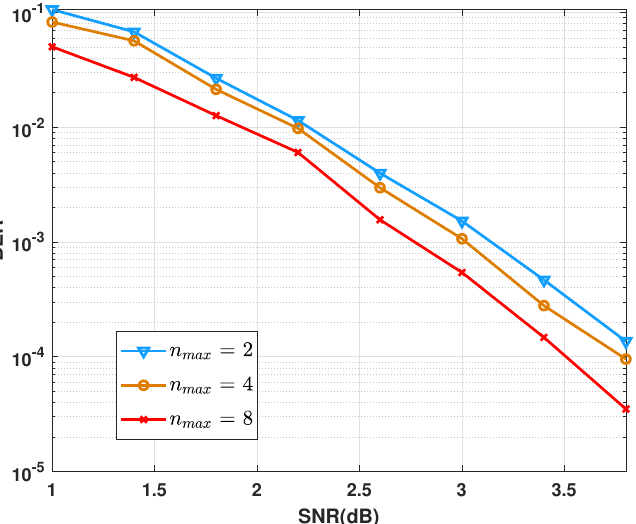
Figure 9. BER comparison of IBPL decoder under different number of maximum decoding paths when the code length is 128 bits and the code rate is 1/2.